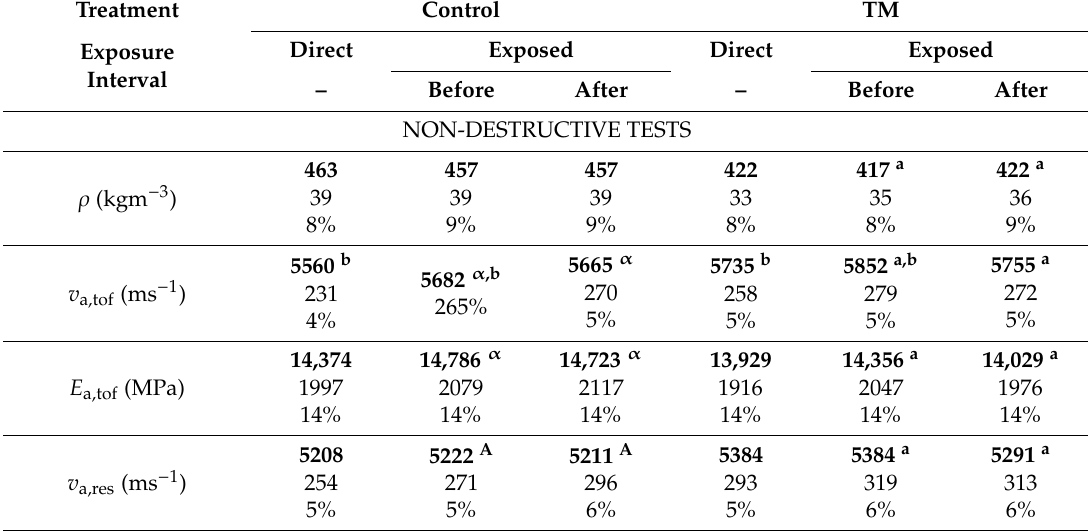
Table 4. Mean value (upper and bold), standard deviation (middle) and coe ffi cient of variation (lower) for various properties of control and TM boards tested directly, and before and after